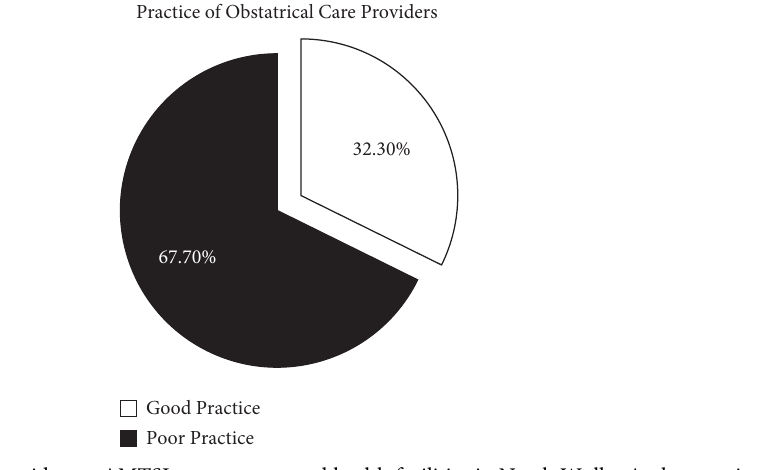
Figure 2: Practice of obstetric care provider on AMTSL at governmental health facilities in North Wollo, Amhara region, Ethiopia,